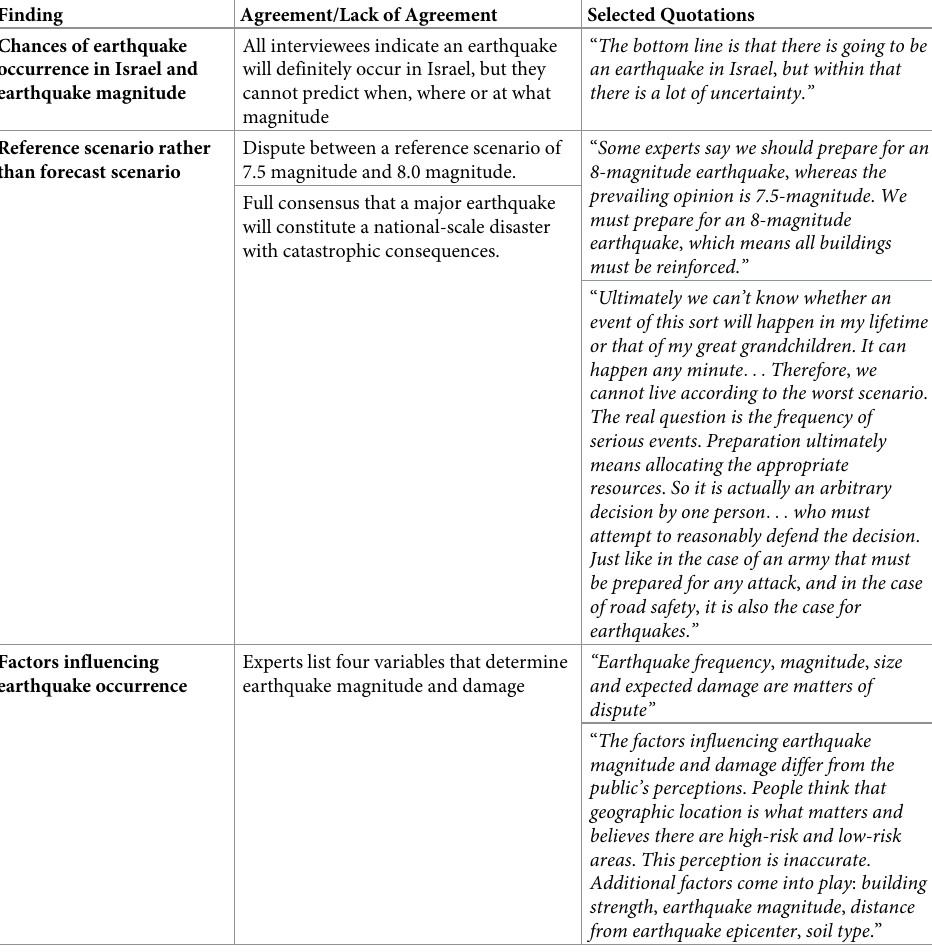
Table 2. Interviews with the experts: Findings and selected quotes regarding the variables associated with earth- quake occurrence (n =